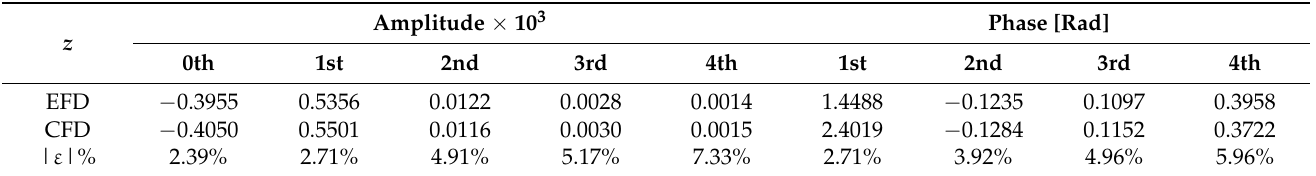
Table 6. Harmonic amplitudes and phases of heave ( z ) for the FRxz ϕθ head waves scenario.